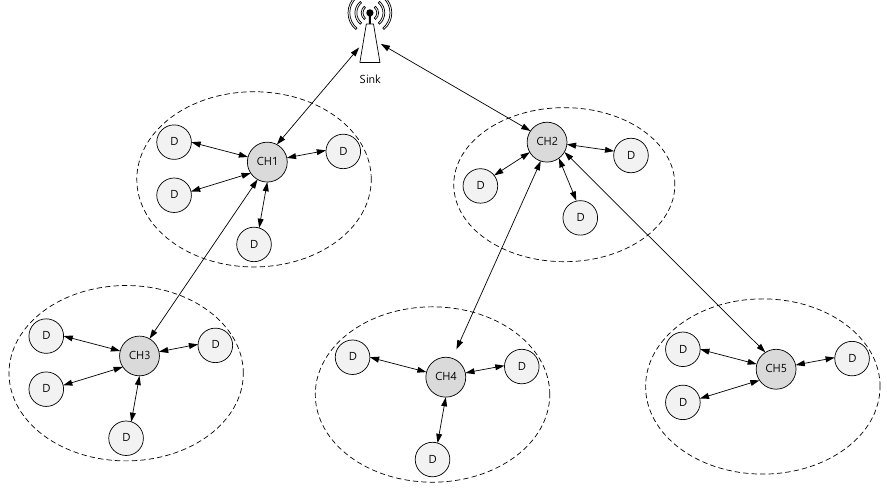
Figure 9. Simulation topology.